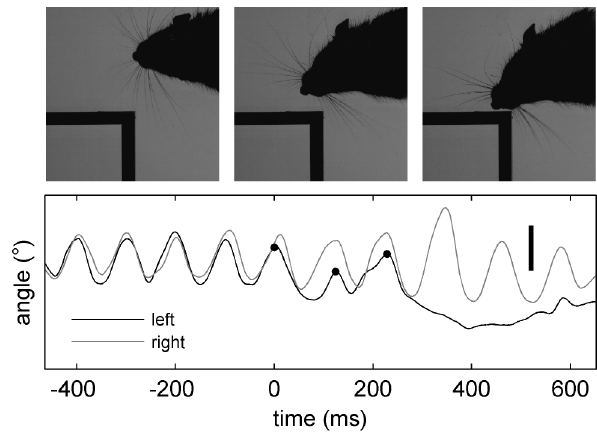
Figure 1. Rat behaviour. (Top) Three still frames from a top-down video recording of a rat encountering and orienting to the corner of a square object with vertical walls (data from [20]). Each successive frame is at approximately the time of maximum protraction of three consecutive ‘whisks’ (t=0 ms, 120 ms, 230 ms)—the first is that immediately following the rat’s first contact with the object. Two behavioural responses can be seen in the subsequent frames: (i) the whiskers are positioned asymmetrically around the snout and (ii) the tip of the snout is brought to the point of contact with the object. The whole video (covering the same time range as the plot) is available as Video S1. (Bottom) Average bilateral protraction angle of the whiskers recovered from the same video over a time period covering the encounter (left/right is black/grey; vertical scale bar has length 30 u ). Main feature of these signals until contact at t=0 ms is periodic protraction and retraction known as ‘whisking’. The times of the three still frames are marked as dots on the trace from the left hand whiskers (see main text).